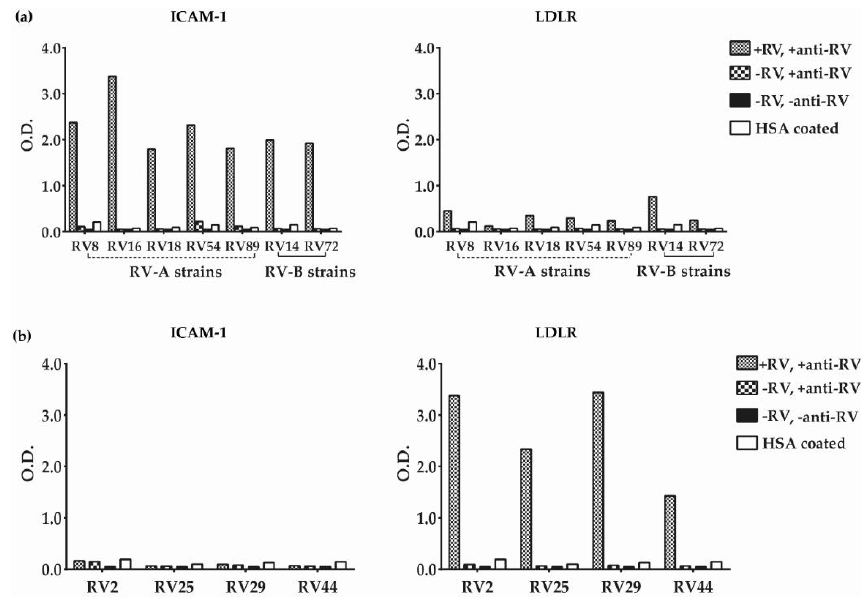
Figure 3. Binding of major group and minor group RVs to ICAM-1and LDLR. Shown are O.D. values (y-axes) corresponding to receptor (ICAM-1 or LDLR)-bound ( a ) major or ( b ) minor group RVs (x-axes) as determined by ELISA. Tested major group RV-A or RV-B species ( a ) and minor group RV-A species ( b ) are indicated on the x-axes. The analyses were performed with virus (50 µ g / mL RV) and, for control purposes, without virus ( − RV), without virus and detection antibodies ( − RV, − anti-RV) or with HSA- instead of receptor-coated plates (HSA coated). The results are means of duplicate determinations with a variation of less than 5%. RV–receptor binding experiments were repeated two times.